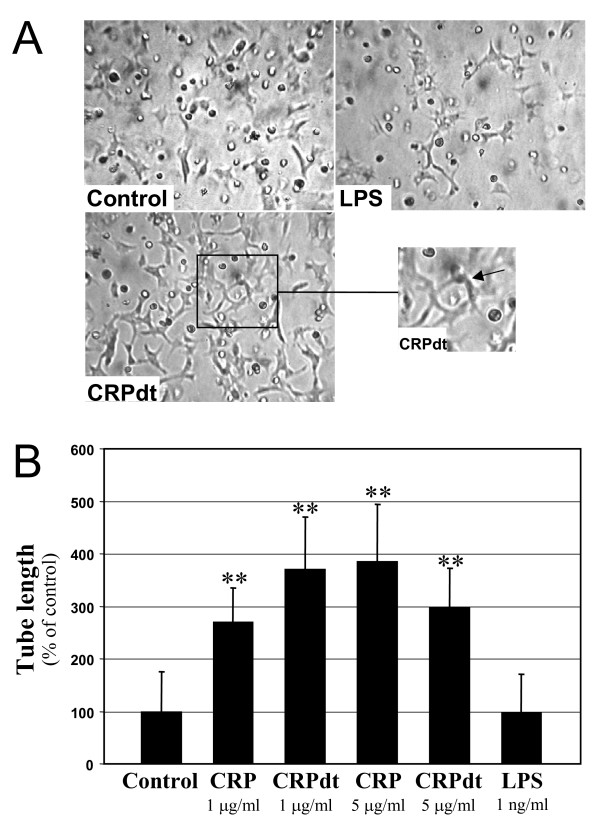
CRP induced tube-like structure formation in HCAEC. A, Representative images from control cells and cells treated with 1 ng/ml LPS or 1 μg/ml of detoxified CRP [CRPdt] for 24 h are shown. B, Bar graph showing tube length as a percentage of control. Experiments were performed at least twice by triplicate. ** indicates a statistically significant difference compared with the control (p < 0.001).